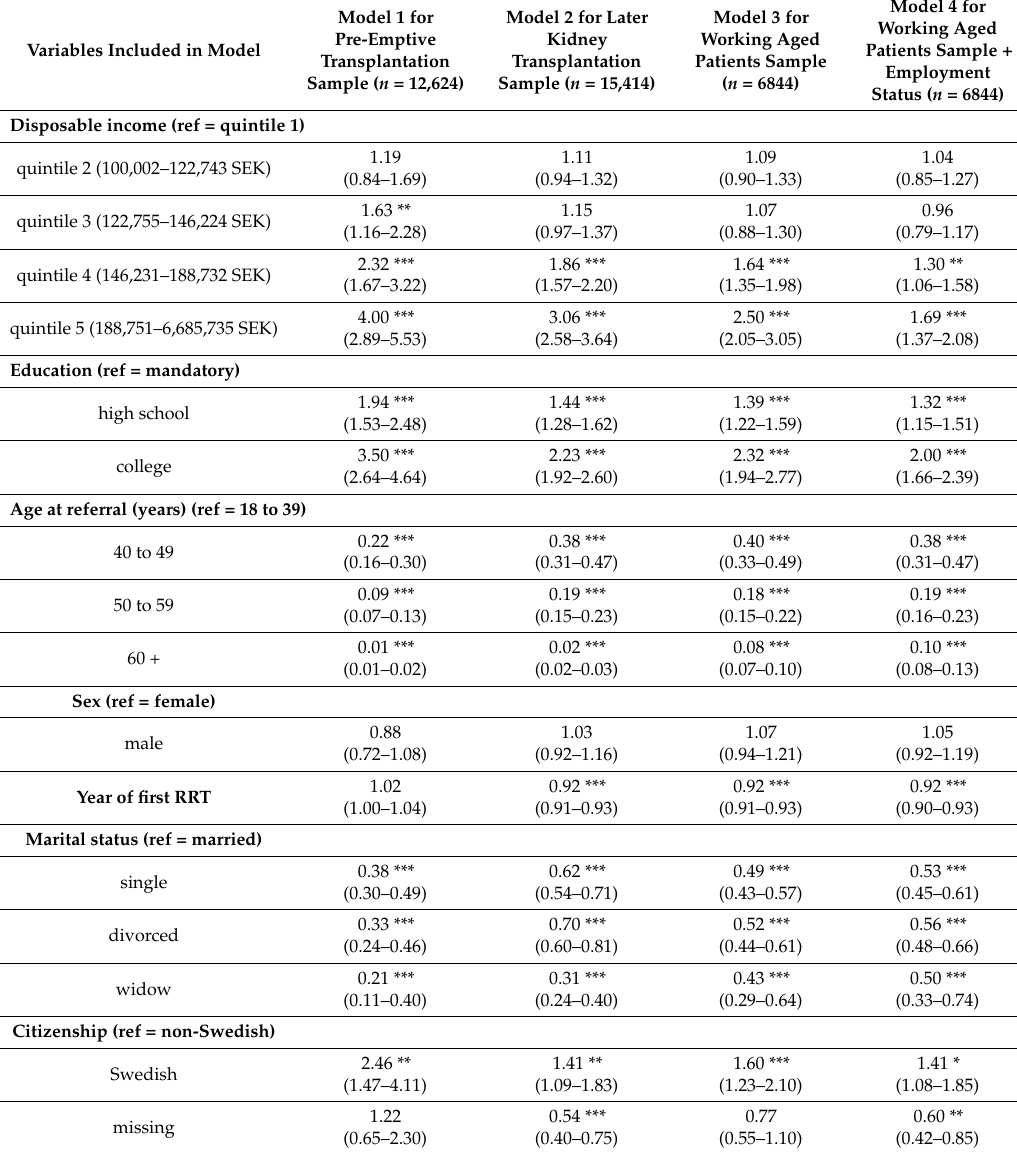
Table 4. Sensitive analyses for income by the multivariate logistic